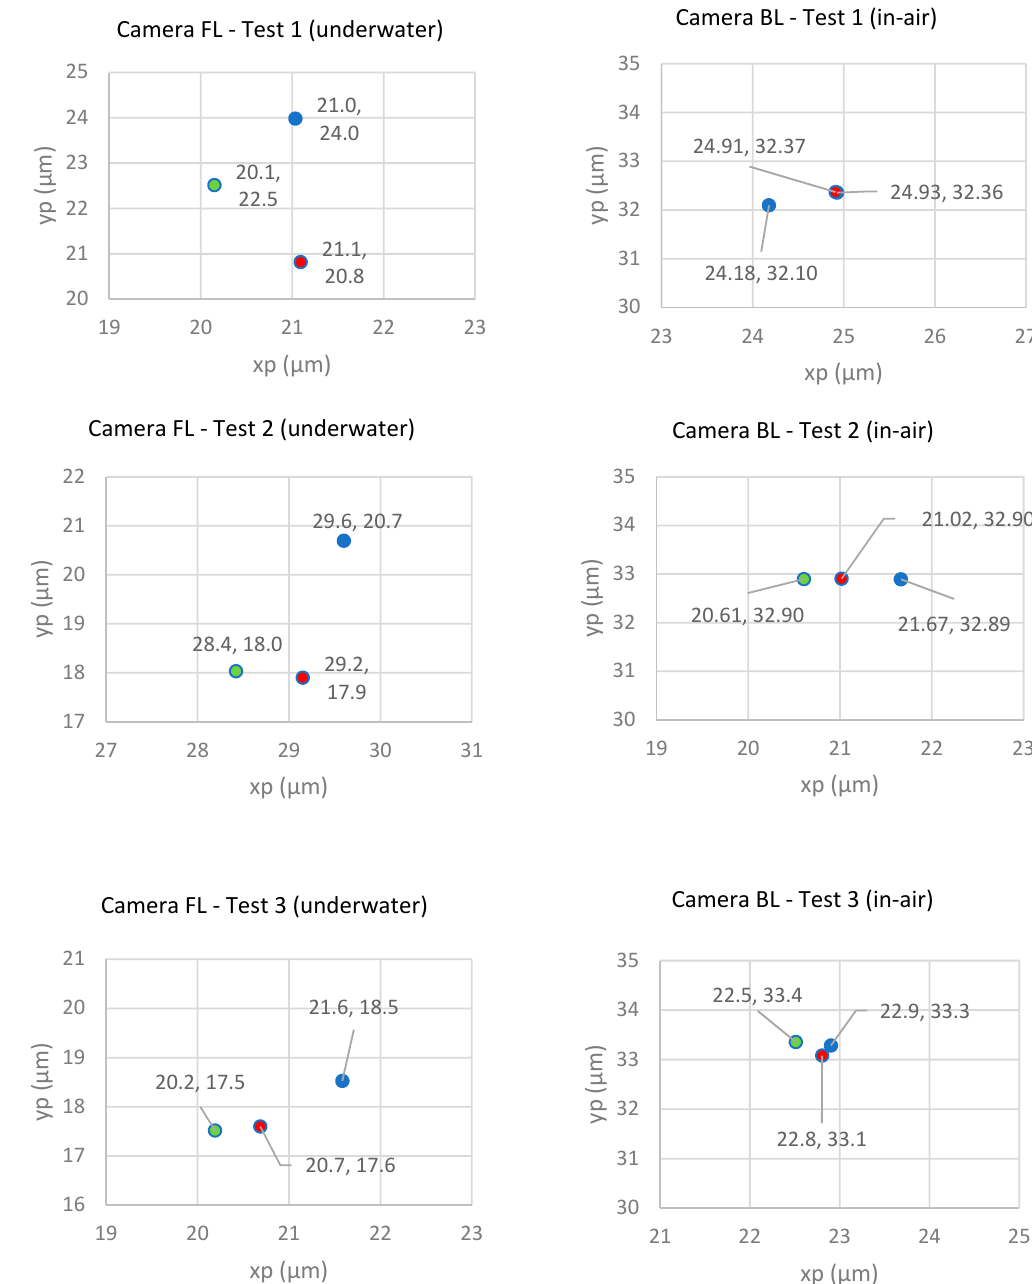
Figure 12. Comparison of the calculated principal point offsets for the camera FL underwater ( left column) and the camera BL ( right column) for the overall three repeats (rows) using the CMB adjustment. The colours indicate the results for the different bands (blue, green, red).